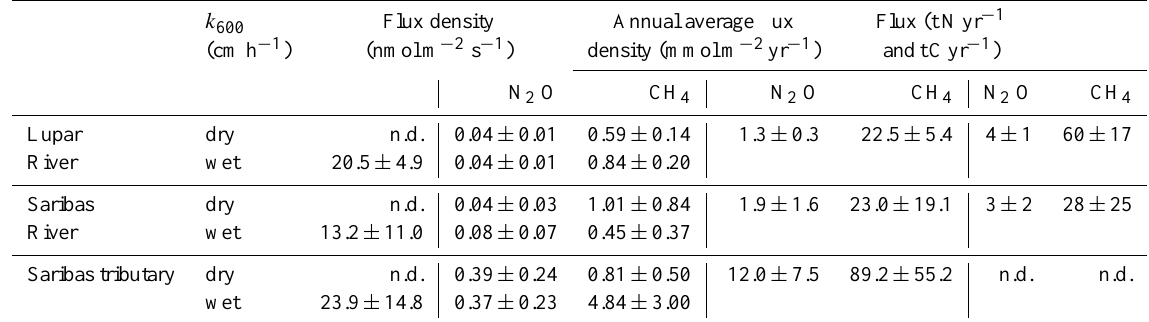
Table 4. k 600 values and median N 2 O and CH 4 areal and total fluxes from the Lupar River, Saribas River, and Saribas tributary. The uncertainties relate to the maximum variability of the k 600 value, as the k 600 uncertainty propagation was responsible for approximately 96% of the flux uncertainty. Values are given for the spatial extent of the rivers that was covered in 2013. k